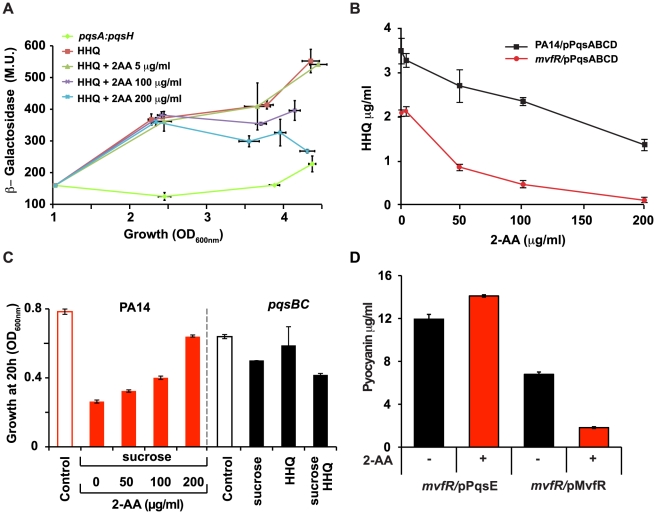
Negative regulation of the MvfR regulon by 2-AA is a result of down-regulation of pqsABCDE expression and interference with MvfR activity via inhibition of HHQ biosynthesis.(A) pqsA promoter response was assessed by measuring pqsA-LacZ expression in the PA14 isogenic pqsA::pqsH double mutant in the presence of HHQ (10 µg/ml) or HHQ together with 2-AA at the indicated concentrations. β-galactosidase activity is given in Miller Units, and plotted against growth assessed at OD600 nm. The experiment was repeated three times with similar results. (B) Levels of HHQ in the supernatant (OD 2.0) of PA14 and mvfR mutant cells constitutively expressing pqsABCD on a plasmid. HHQ levels were quantified in triplicate by LC/MS. The error bars represent the standard deviation of triplicate samples. (C) Growth of PA14 and pqsB::C mutant cells carrying pqsA-SacB after 20 h of inoculation in the presence or absence of sucrose (10%), and/or with exogenously added various concentrations of 2-AA. The pqsA promoter of pqsA-SacB in the pqsB::C mutant was induced by exogenous addition of 10 µg/ml HHQ where indicated. (D) Concentration of pyocyanin in mvfR mutant cells (OD 3.0) over-expressing MvfR or PqsE under a constitutive promoter in the presence or absence of 2-AA (200 µg/ml). Error bars represent standard deviations of triplicate samples. These experiments were repeated at least three times with similar results.